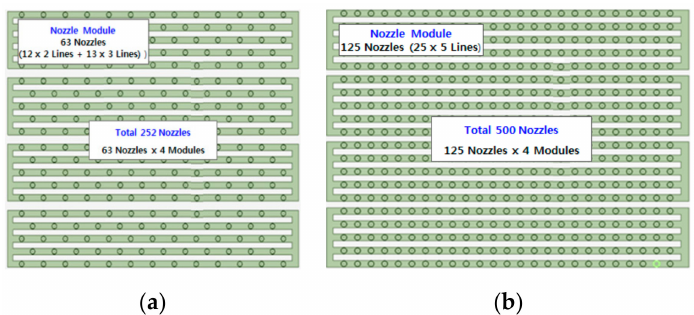
Figure 10. Shapes of newly proposed test apparatus: ( a ) new design (A) with total 252 burners in four modules; ( b ) new design (B) with total 500 burners in four modules.